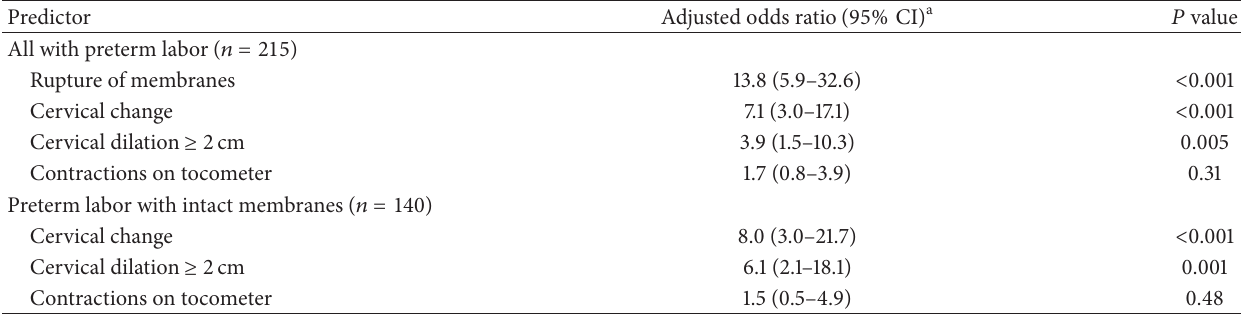
Table 3: Multivariable analysis of predictors associated with optimal timing of antenatal